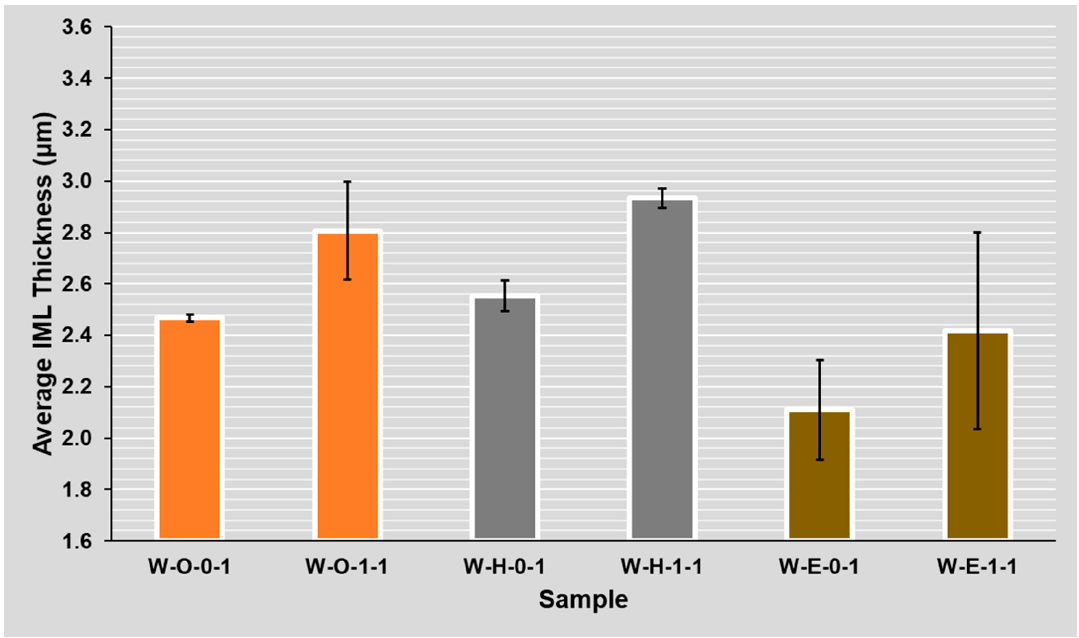
Figure 12. Flux type influence on the average IML thickness for samples with the W hite solder mask ( B lack/ W hite)—( O SP, H ASL, E NIG)—(ROL 0 , ROL 1 )—( 1 , 2 reflows).